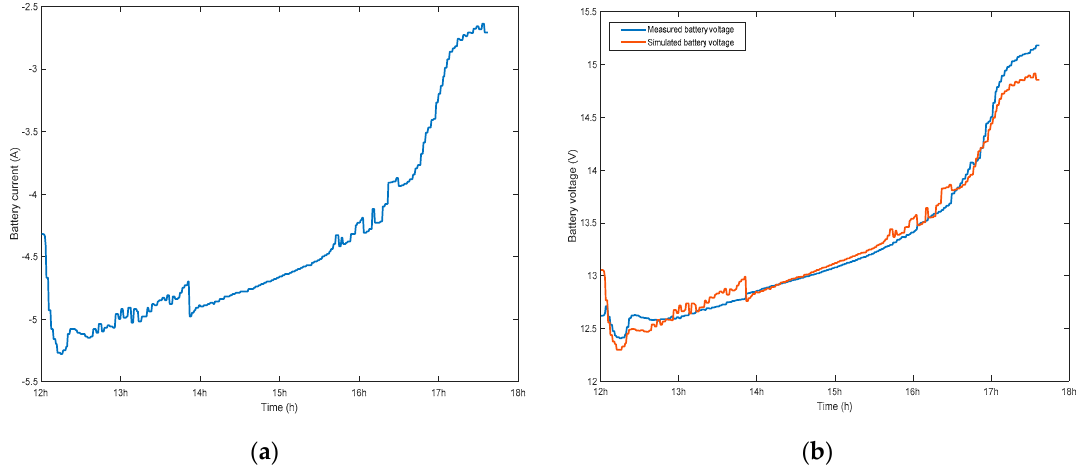
Figure 5. ( a ) The battery’s current in the charging mode; ( b ) The simulation and experimental battery’s voltage in the charging mode.